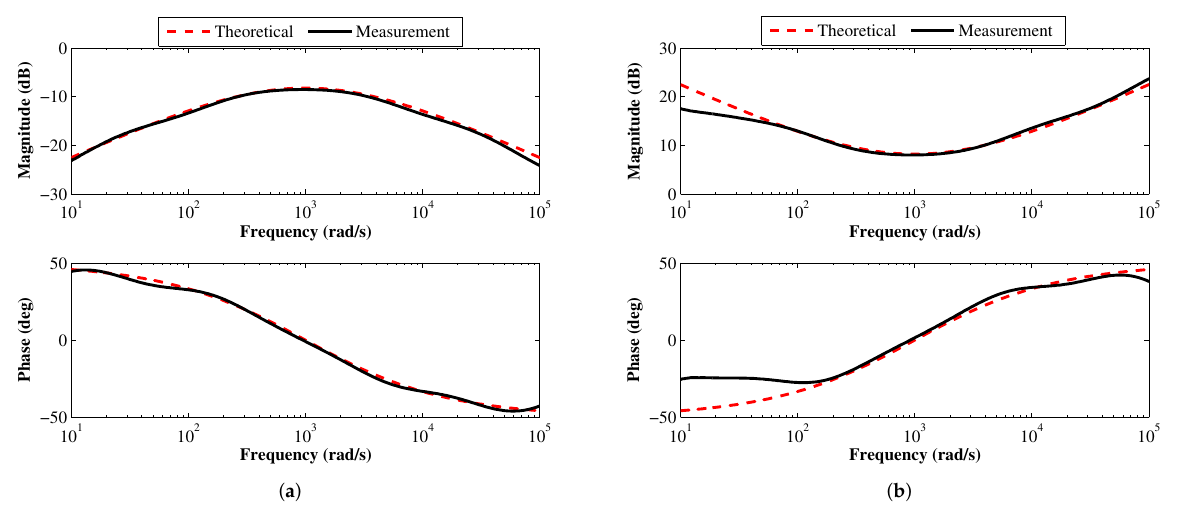
Figure 14. Magnitude and phase responses of the proposed ( a ) FBPF and ( b ) FIBPF based on experimental